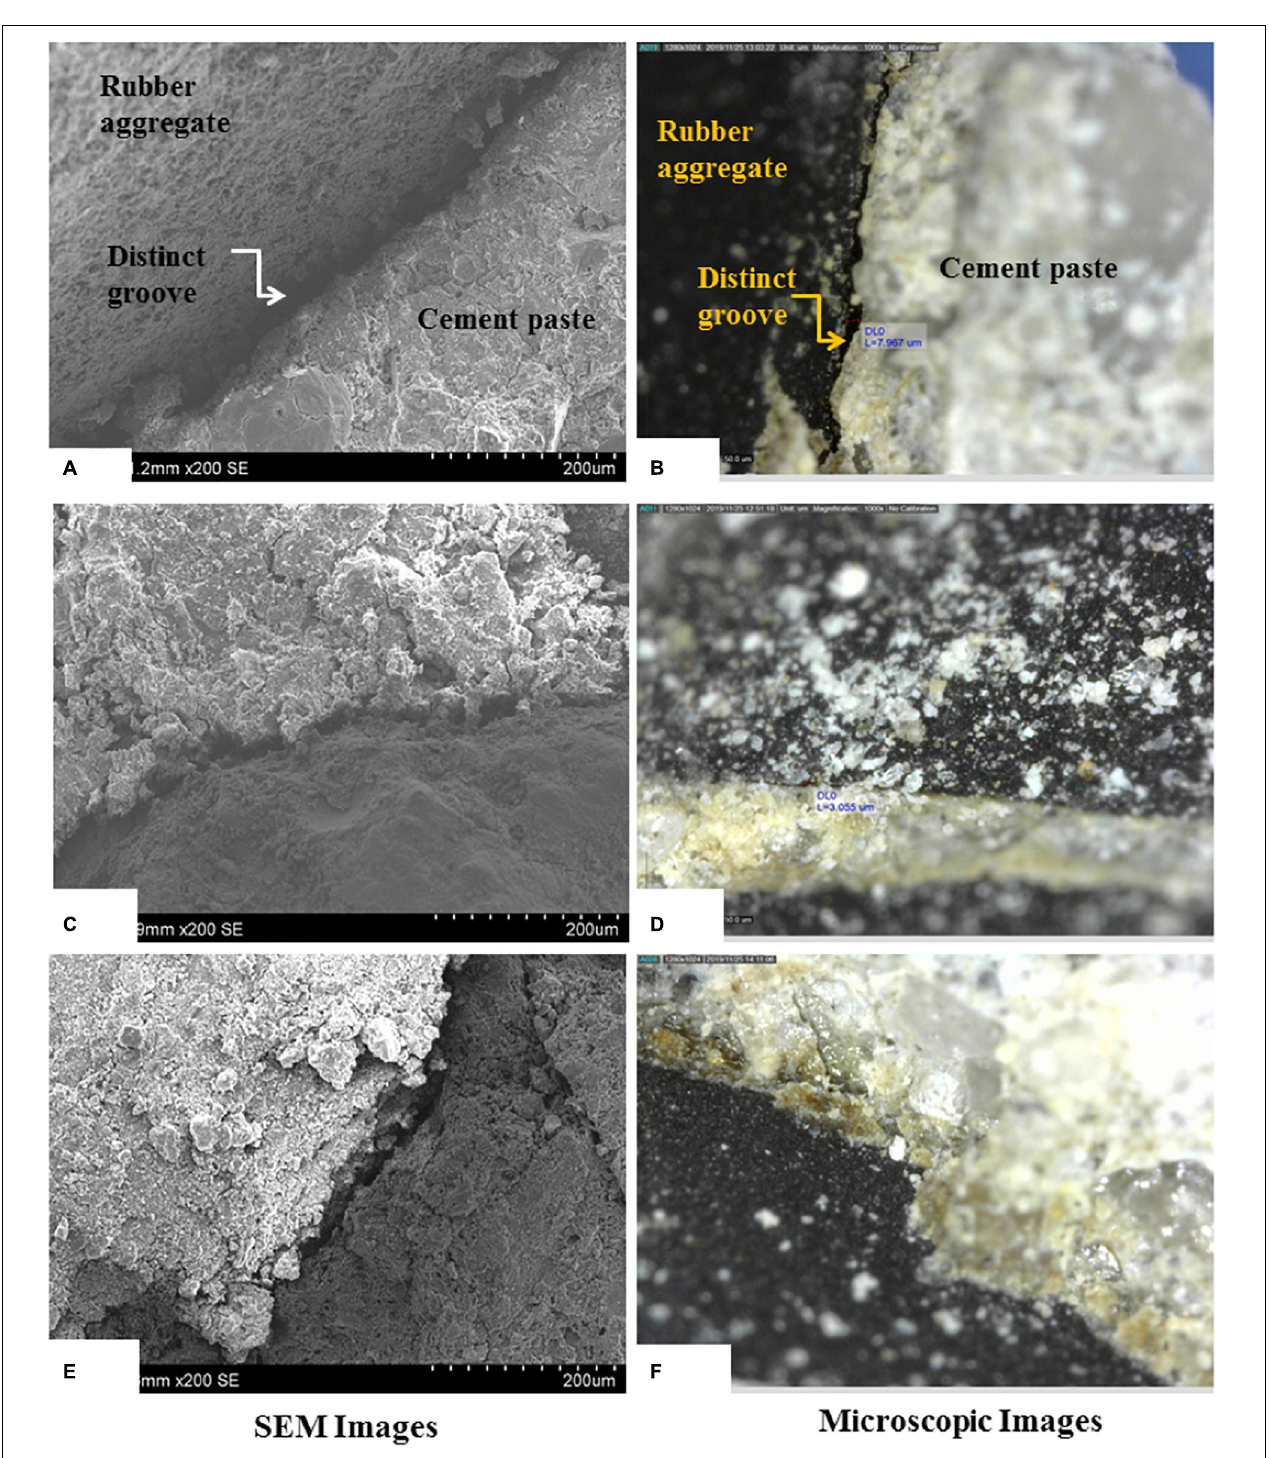
FIGURE 8 | SEM and microscopic images of concrete made with rubber aggregates treated for 72 h in (A,B) water, (C,D) NaOH, and (E,F) Ca(ClO) 2 .